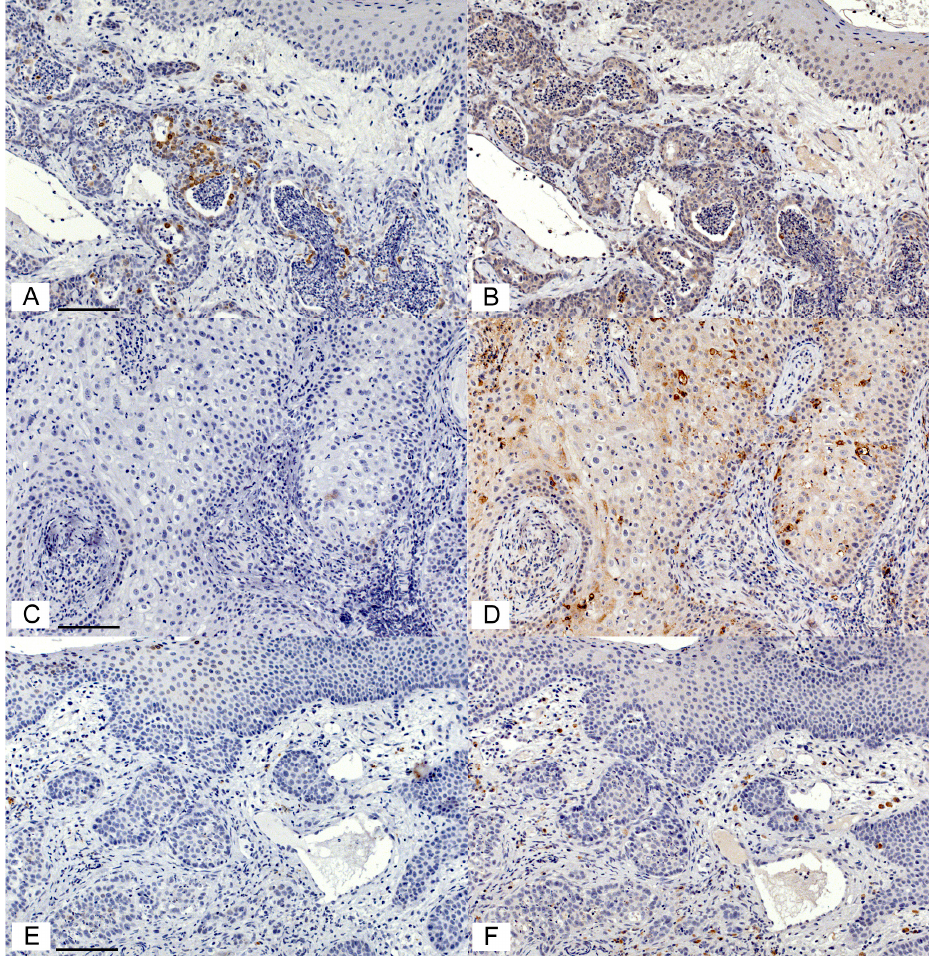
Figure 2. COX-2 and CD147 expression varied between cases of feline OSCC. Photomicrographs of IHC staining using rabbit anti-COX-2 IgG (1:200) and goat anti-CD147 IgG (1:100). The chromogen is DAB (brown), and the counterstain is hematoxylin (blue). Case 1: There are scattered OSCC cells